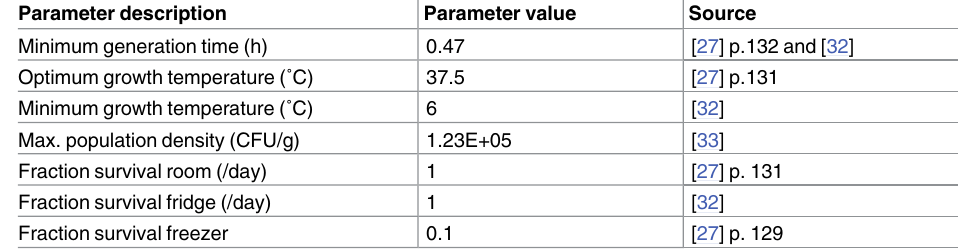
Table 3. Values used for EEC growth and survival parameters related to storage.